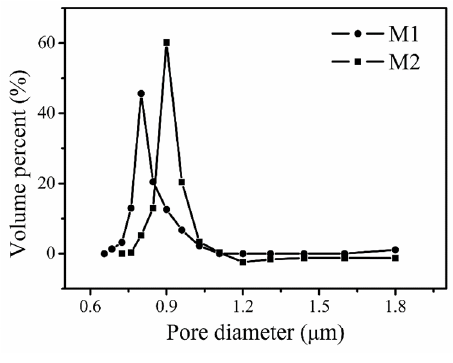
Fig. 5 Pore size distributions of the membranes.